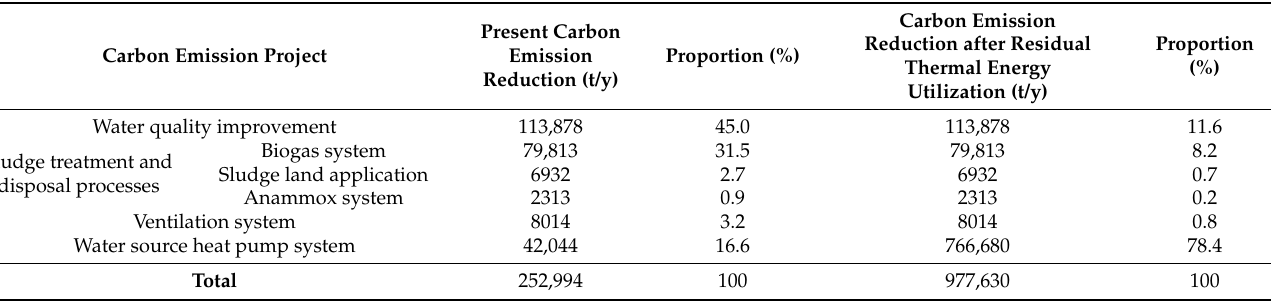
Table 8. Calculation of the total carbon emission